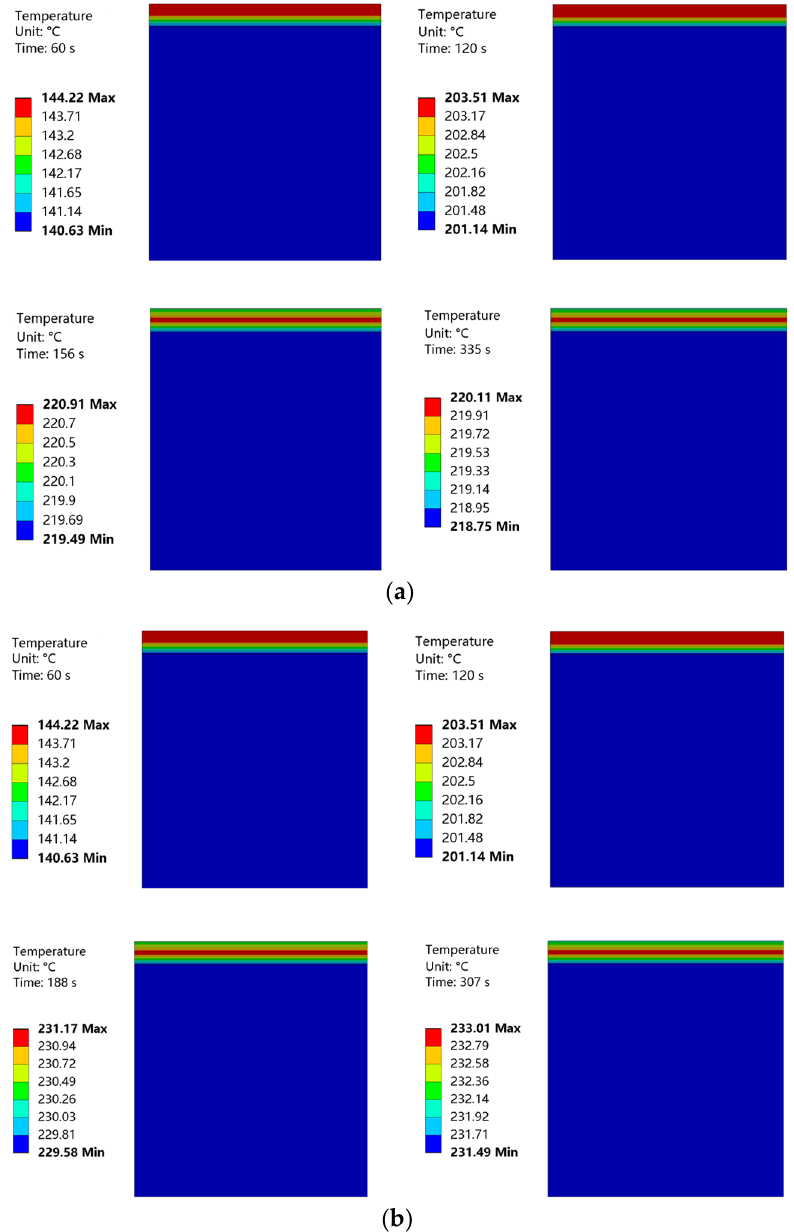
Figure 21. ( a ) Temperature nephogram of coating and substrate at a curing temperature of 220 °C. ( b ) Temperature nephogram of coating and substrate at a curing temperature of 230 °C.